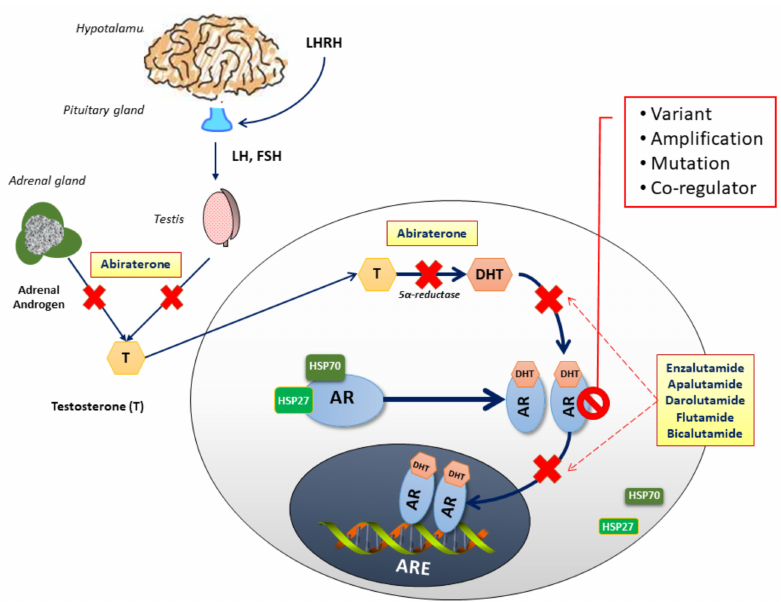
Figure 1. Androgen-dependent signaling through the androgen receptor (AR). After its production in the testes ad the adrenal glands, testosterone (T) is converted by 5 α -reductase to dihydrotestosterone (DHT), its active metabolite. Generally, androgens bind to AR, dissociating chaperone proteins, including members of the heat shock protein family (HSP27 and HSP70). Upon homodimerization, ligand-bound AR dimers translocate to the nucleus where they bind to androgen response elements (ARE), acting as transcription factors to downstream targets. AR-directed drugs are illustrated at their points of pathway alteration: Abiraterone disrupts the androgen biosynthesis inhibiting the 17 α -hydroxylase/C17,20-lyase (CYP17), an enzime expressed in testicular, prostate, and adrenal tissue; Flutamide, and Bicalutamide, reversibly, and Enzalutamide, Apalutamide, Darolutamide, irreversibly, prevent testosterone binding to the AR, incapacitating its translocation to the